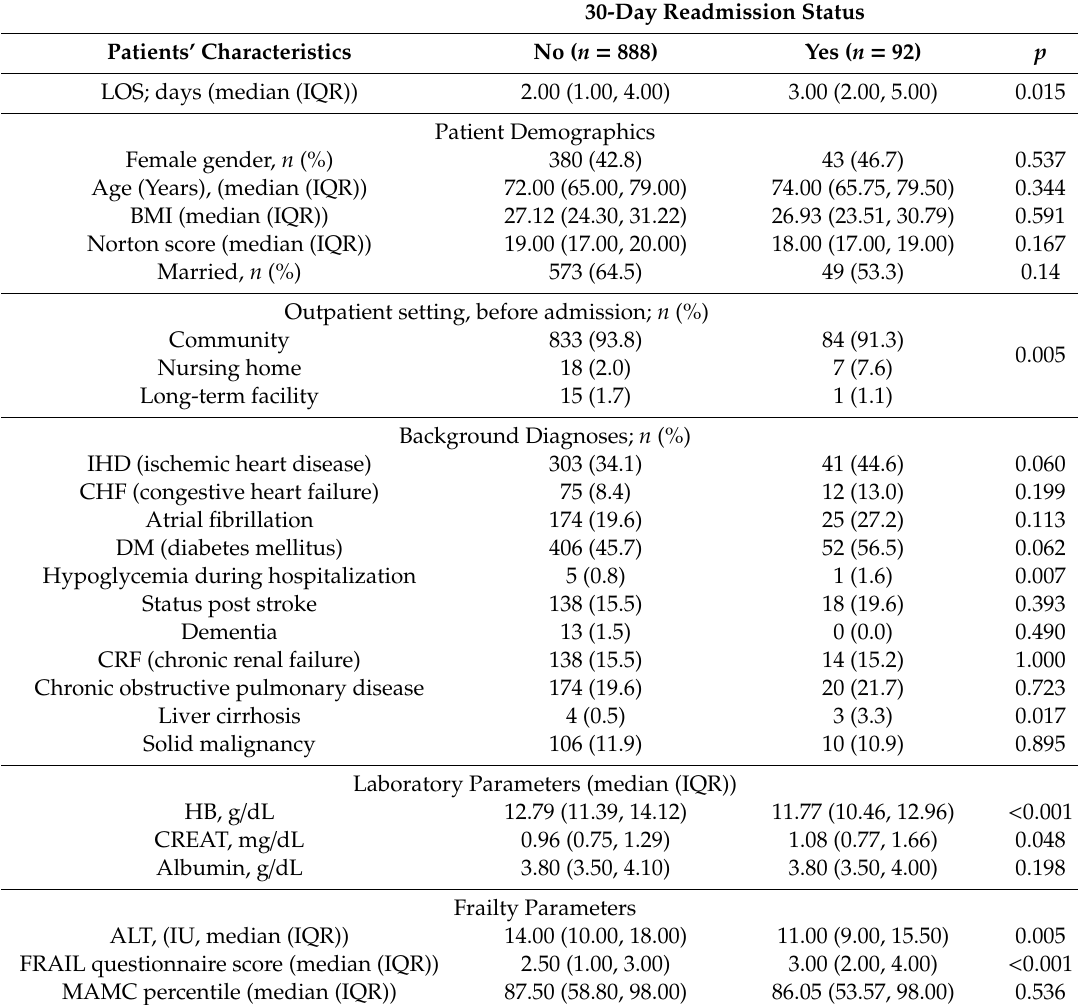
Table 1. Patients’ characteristics according to 30-day readmission